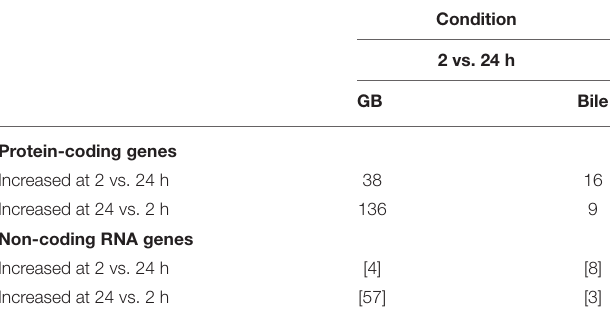
TABLE 4 | Summary of the number of genes found to be differentially expressed when the 2 and 24 h time points for each condition were compared to each other.